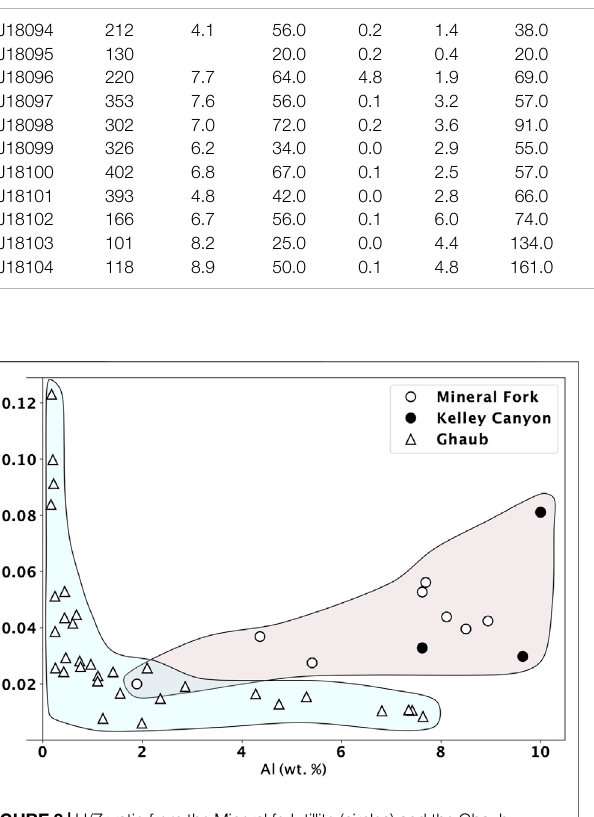
FIGURE 3 | U/Zr ratio from the Mineral fork tillite (circles) and the Ghaub Formation (triangles) plotted against Al concentration. Uranium and Zr are similar geochemically, except U is redox sensitive and Zr is not. Therefore, correlation of this ratio with Al, a proxy for detrital in fl uence, can distinguish between changing U concentrations caused by detrital input or redox evolution. We suggest thatonly moderate control of Uconcentration by detrital inputisevidentinsamplesfromUtah(MineralForkandKelleyCanyon). In contrast, Ghaub samples show authigenic enrichment in U, with high U at low Alcontent.Ghauband Utah samples showadistincttrend, highlighted by the blue and peach fi